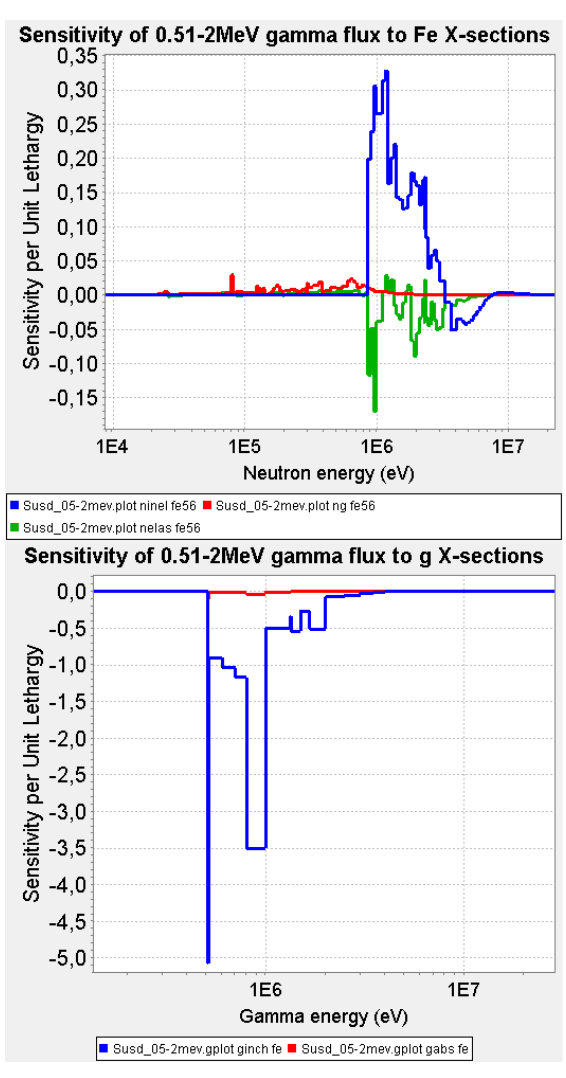
Fig. 5. Sensitivity of gamma flux between 0.51 - 2 MeV at radius 16.3 - 16.8cm to neutron inelastic, elastic and capture (above) and gamma incoherent and absorption (below) cross sections (results for Ø 30 cm